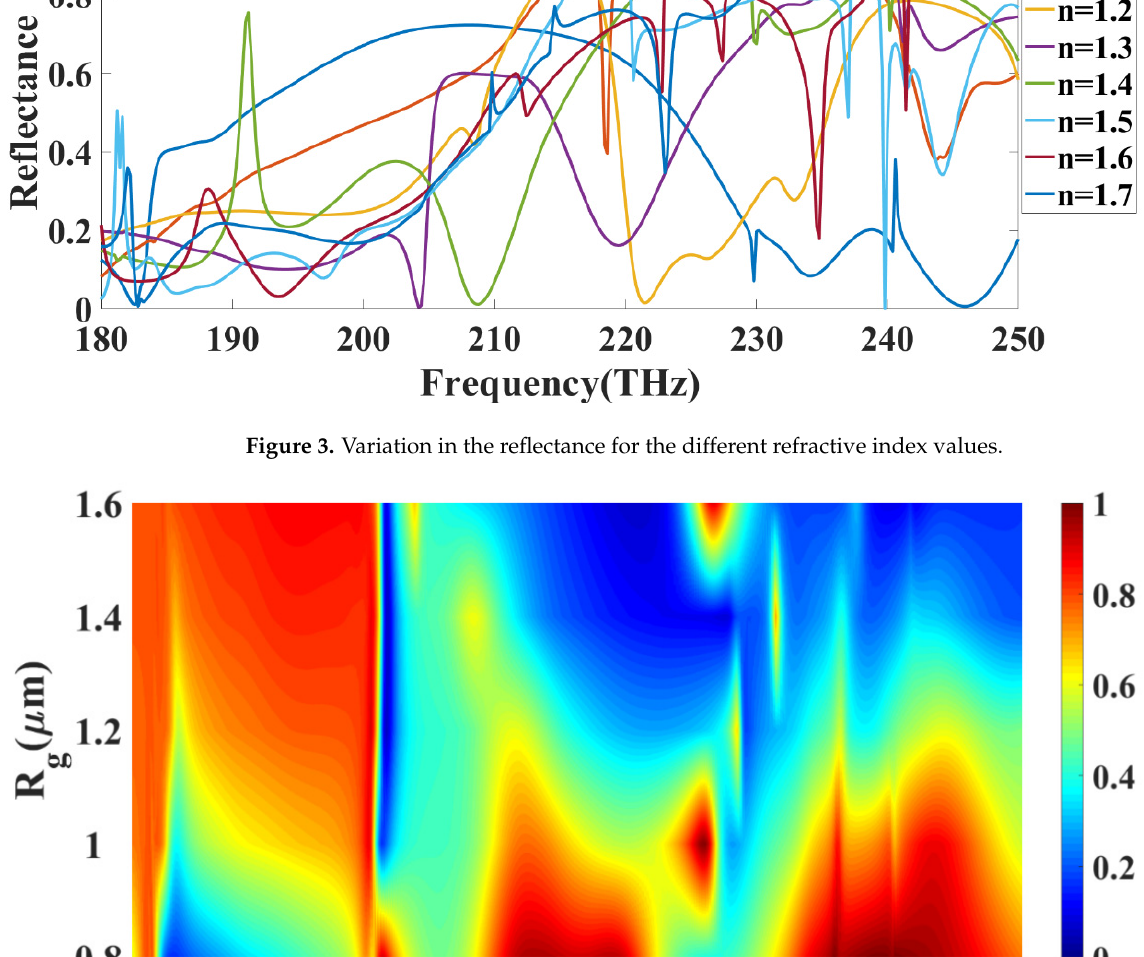
Figure 3. Variation in the reflectance for the different refractive index values.